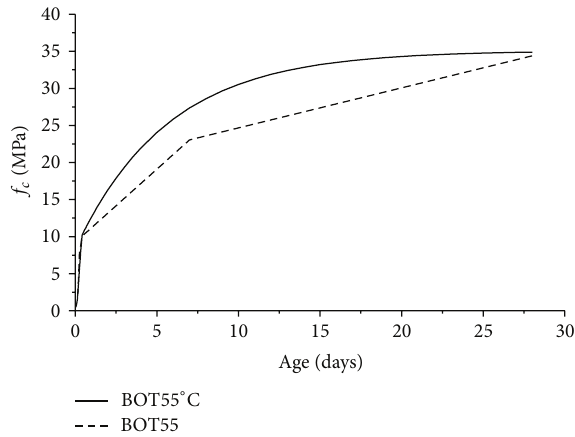
Figure 8: Simulated and experimental strength development curves of heat treated ordinary concrete at 55 ∘